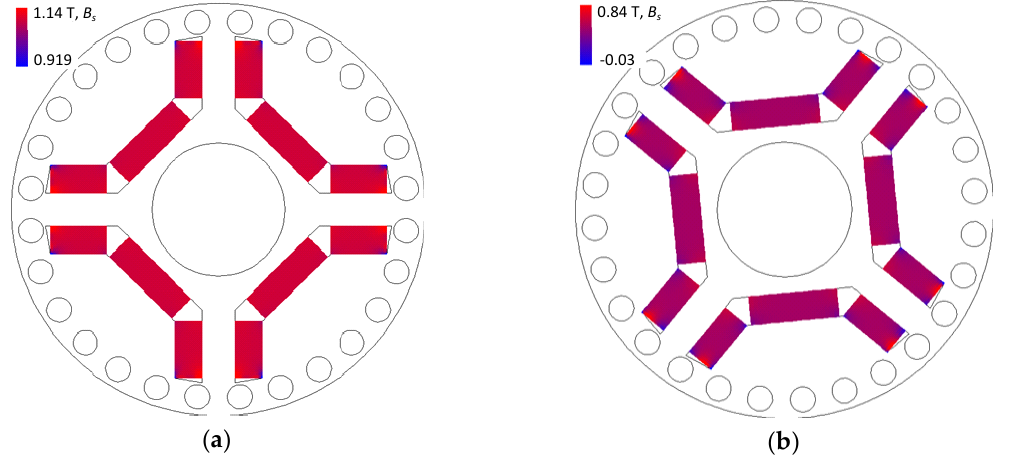
Figure 16. Distribution of magnetic flux density B s for T L = 0 Nm, τ i = 100 ◦ C, J i = 0.0082 kgm 2 : ( a ) before start-up, ( b ) after start-up at t = 0.6